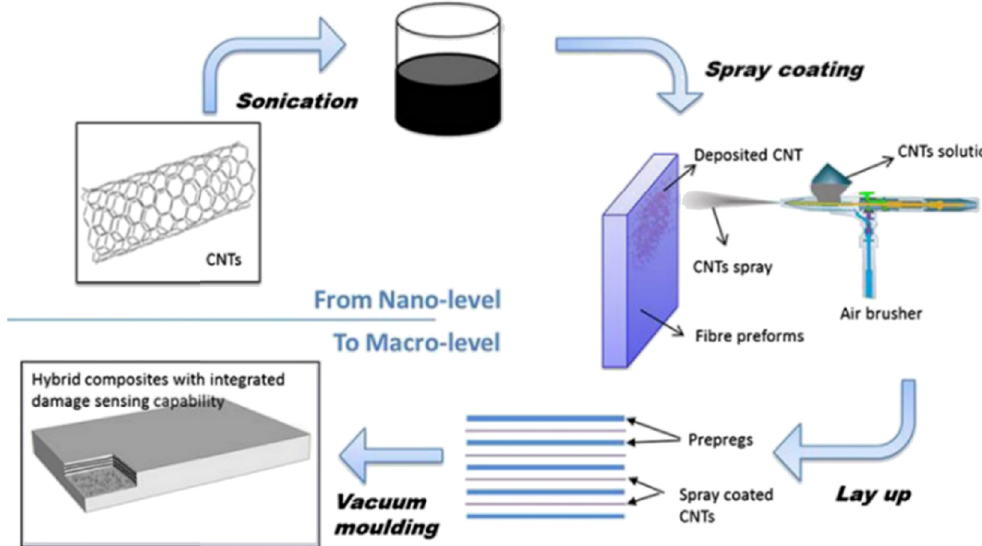
Figure 11: Schematic illustration for the spray coating process [ 33 ]